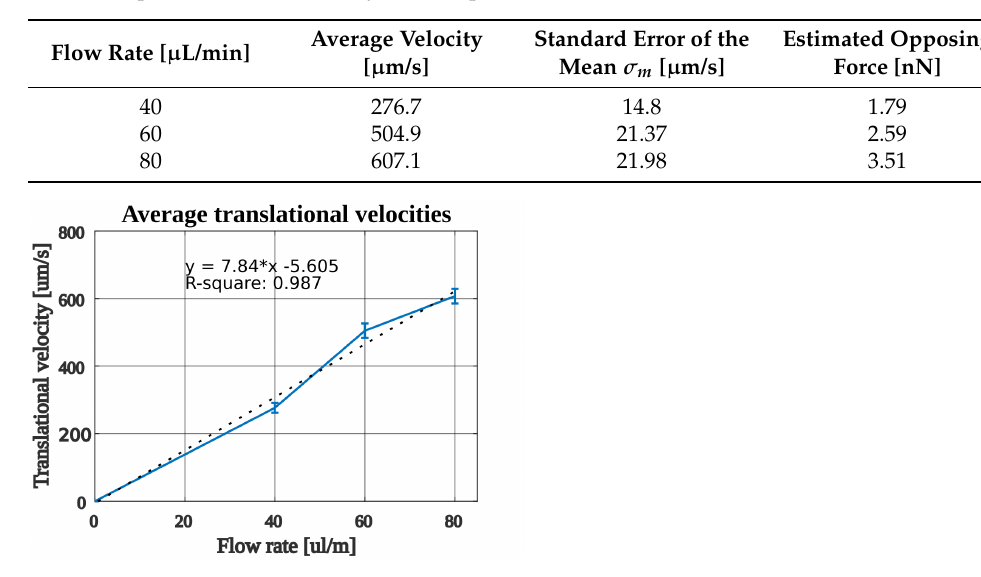
Figure 9. Average crystal translational